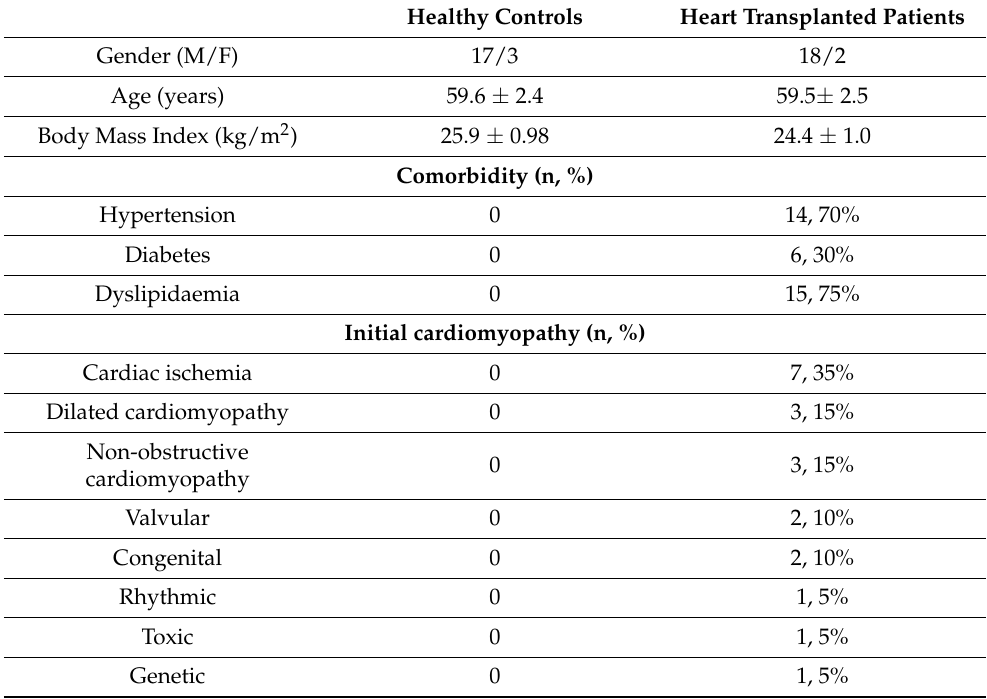
Table 1. Clinical characteristics of the